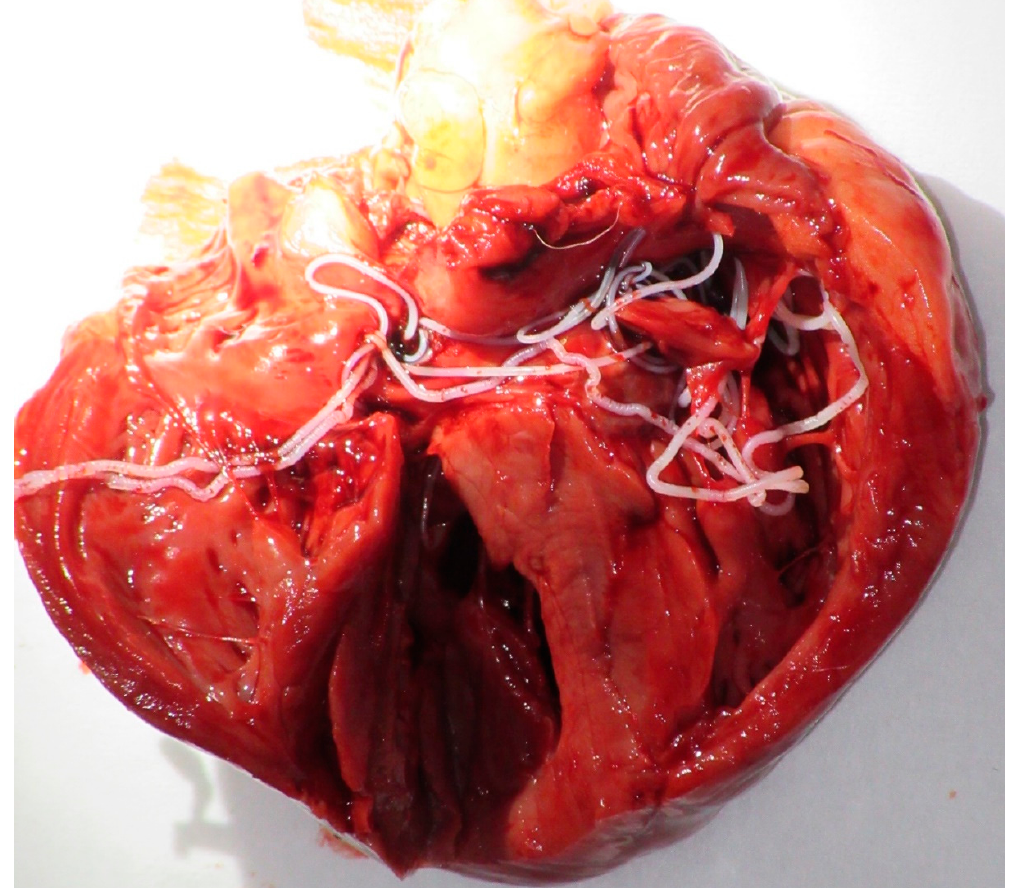
Figure 1. Heartworm ( Dirofilaria immitis ) in the canine heart of dog.